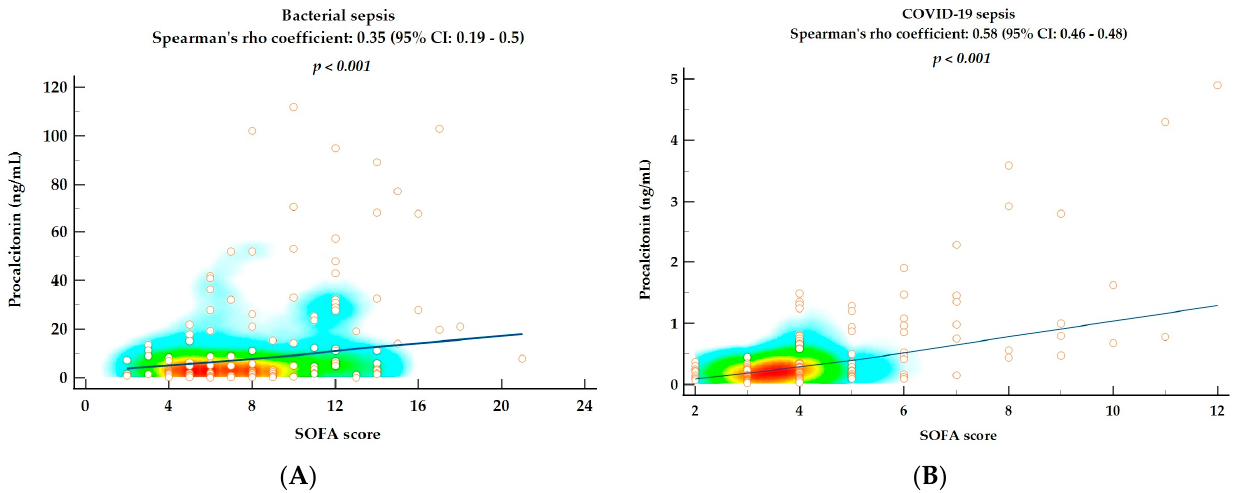
Figure 3. Correlation analysis between procalcitonin and SOFA (Sequential Organ Failure Assess- ment) score using Spearman’s rho coefficient. ( A ) Scatter diagram with heat map and trend line for the correlation between procalcitonin and SOFA score in bacterial sepsis; ( B ) Scatter diagram with heat map and trend line for the correlation between procalcitonin and SOFA score in COVID-19 sepsis. A LOESS smoothing span of 99% was used for the trend lines.